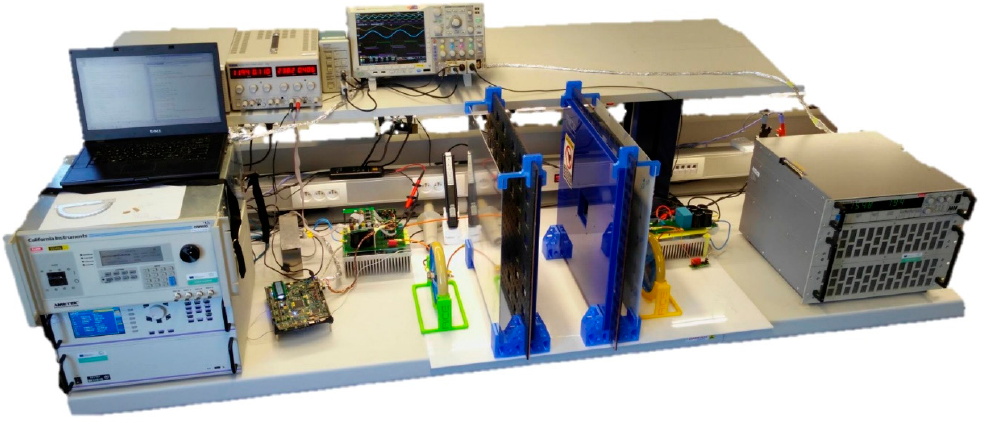
Figure 10. Laboratory prototype of WPT system.